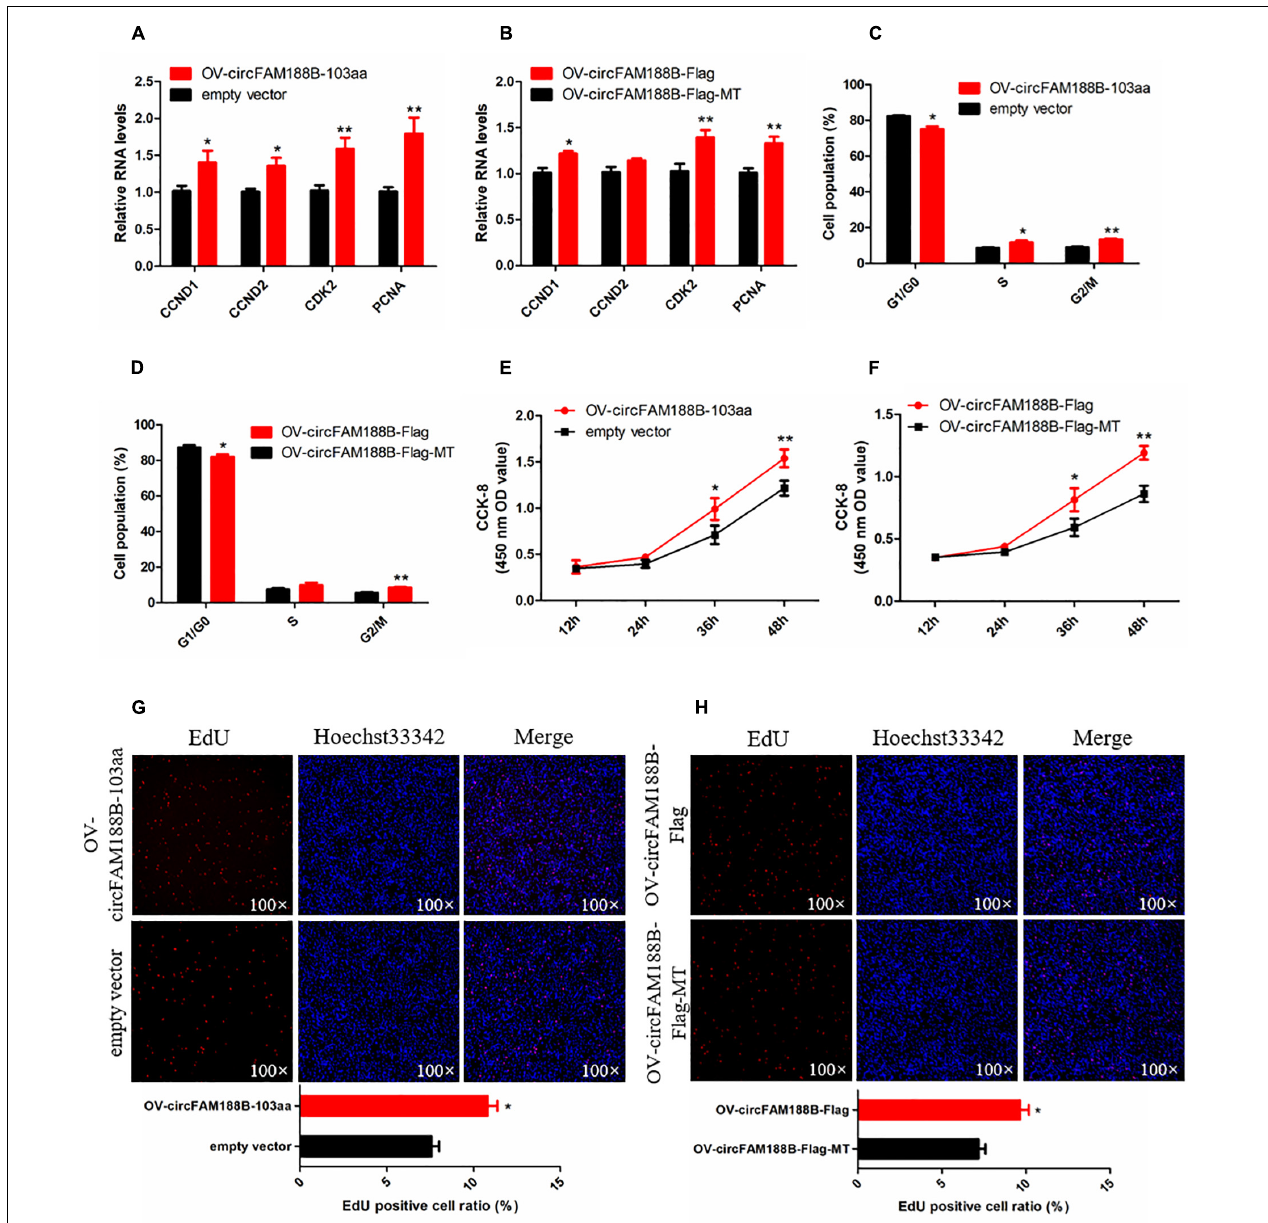
FIGURE 7 | CircFAM188B-103aa promotes proliferation of chicken SMSCs. (A,B) The relative RNA level of cell proliferation-related genes in chicken SMSCs following circFAM188B-103aa overexpression. (C,D) Cell cycle analysis of SMSCs following circFAM188B-103aa overexpression. (E,F) The growth curve of SMSCs following circFAM188B-103aa overexpression. (G,H) Fluorescence microscope images of proliferating chicken SMSCs labeled with EdU following circFAM188B-103aa overexpression (upper panels) . Proliferation rates of chicken SMSCs following circFAM188B-103aa overexpression (lower panels) . The results of all groups are shown as mean ± S.E.M., and the data represent three independent assessment methods. Student’s t -test were used to compare expression levels or values among different groups. * P < 0.05; ** P <